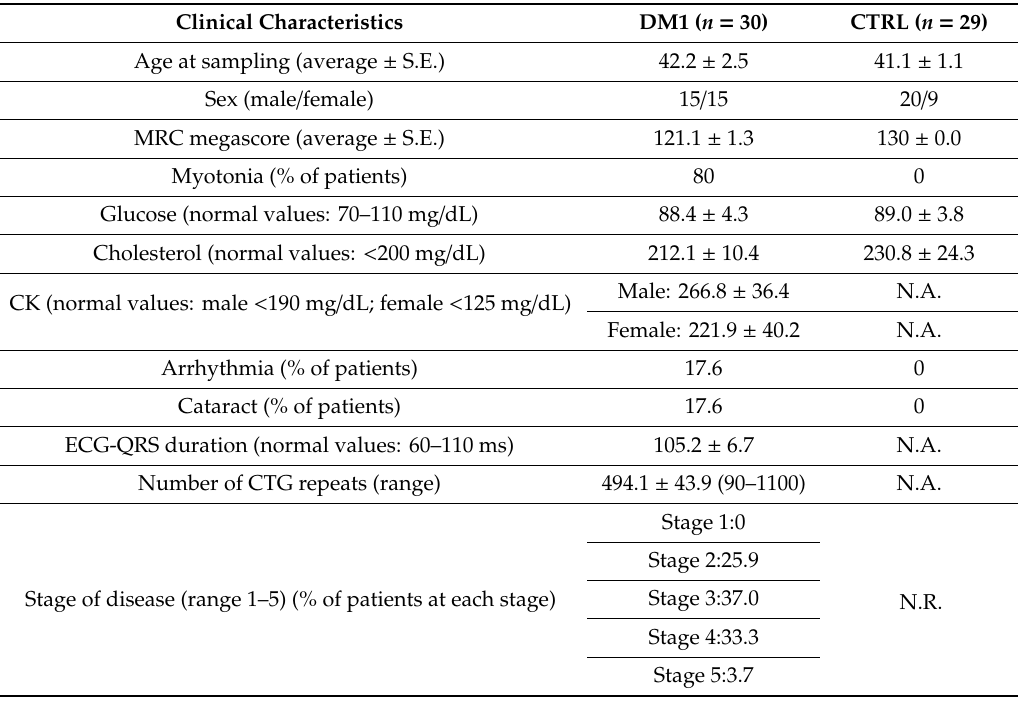
Table 1. Clinical data on myotonic dystrophy type 1 (DM1) and control patients used for validation in biceps brachii biopsies. Legend: N.R., not relevant; N.A., not available. CTRL, controls; S.E., standard error; MRC, Medical Research Counsil; CK, creatine kinase; ECG-QRS, complex of Q, R and S waves